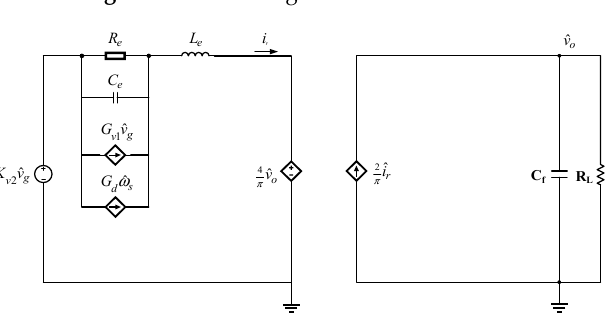
Figure 1. Circuit diagram of LLC converter.